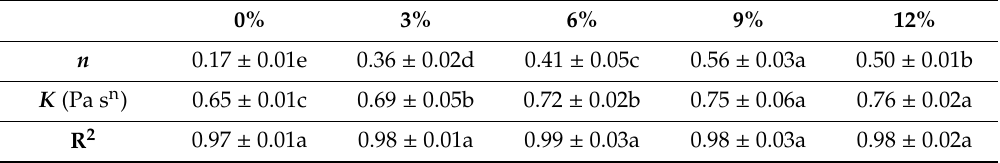
Table 5. E ff ect of Cordia gum on the consistency coe ffi cient ( K ) and flow behavior index ( n ) of corn starch.